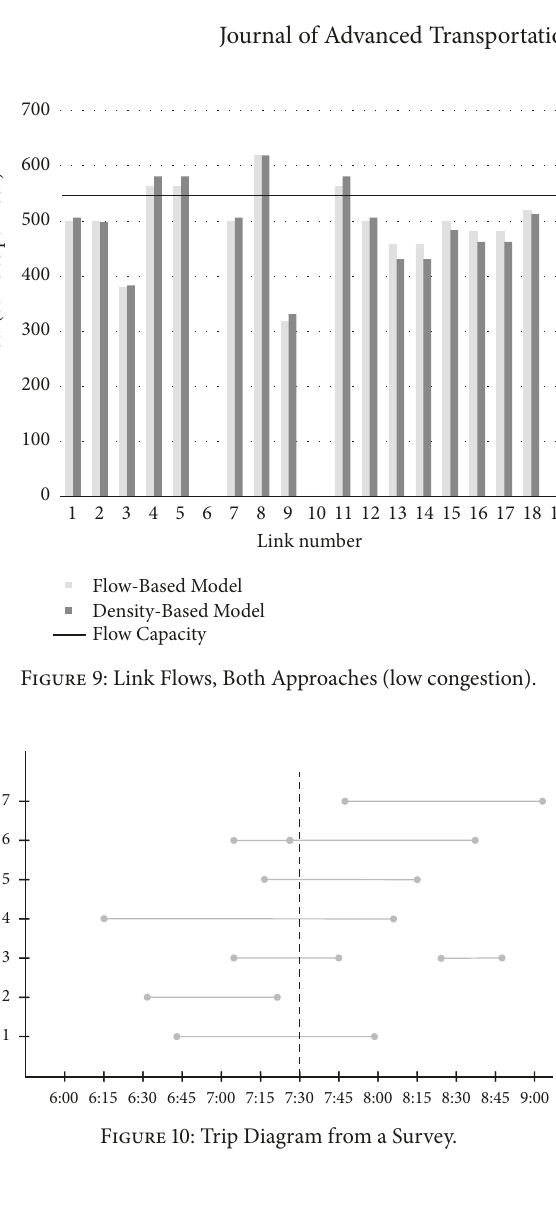
On the vertical axis are the 7 individuals surveyed